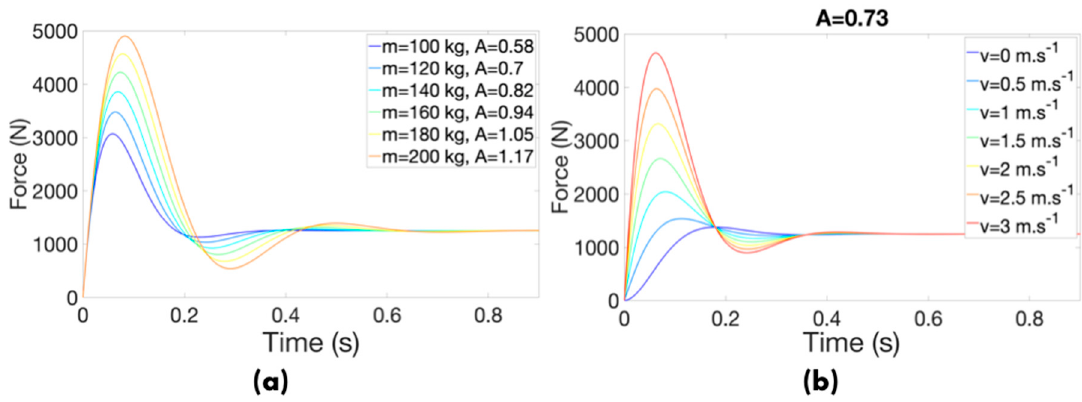
Figure 4. Compression force time evolution with 𝛽 = 3.1 × 10 (cid:2871) 𝑘𝑔.𝑠 (cid:2879)(cid:2869) ,𝑘 = 6.1 × 10 (cid:2872) 𝑁. 𝑚 (cid:2879)(cid:2869) , 𝐹 (cid:2868) = 1250 𝑁 . ( a ) Influence of mass 𝑚 with 𝑣 (cid:2868) = 2.2 𝑚.𝑠 (cid:2879)(cid:2869) on peak force. ( b ) Influence of the engagement speed 𝑣 (cid:2868) with 𝑚 = 115 𝑘𝑔 . We observe that the peak force increases both with engagement speed and